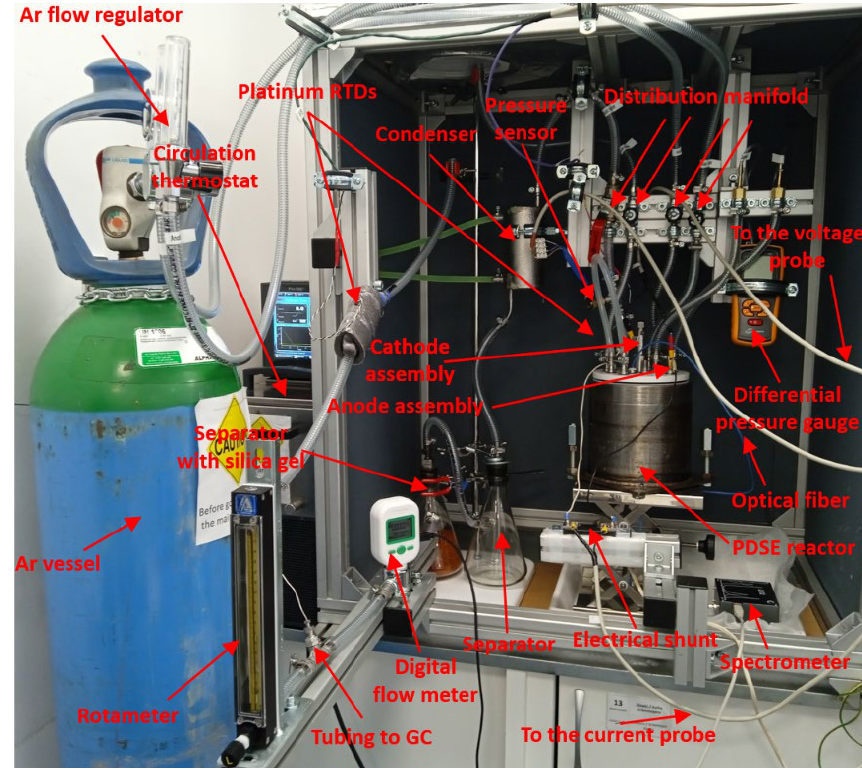
Figure 2. Photo of the experimental setup.